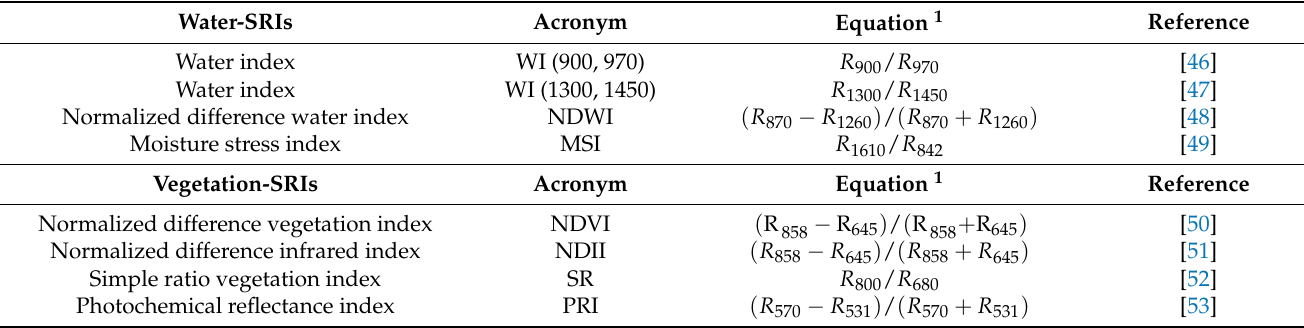
Table 1. Spectral reflectance indices related to leaf water